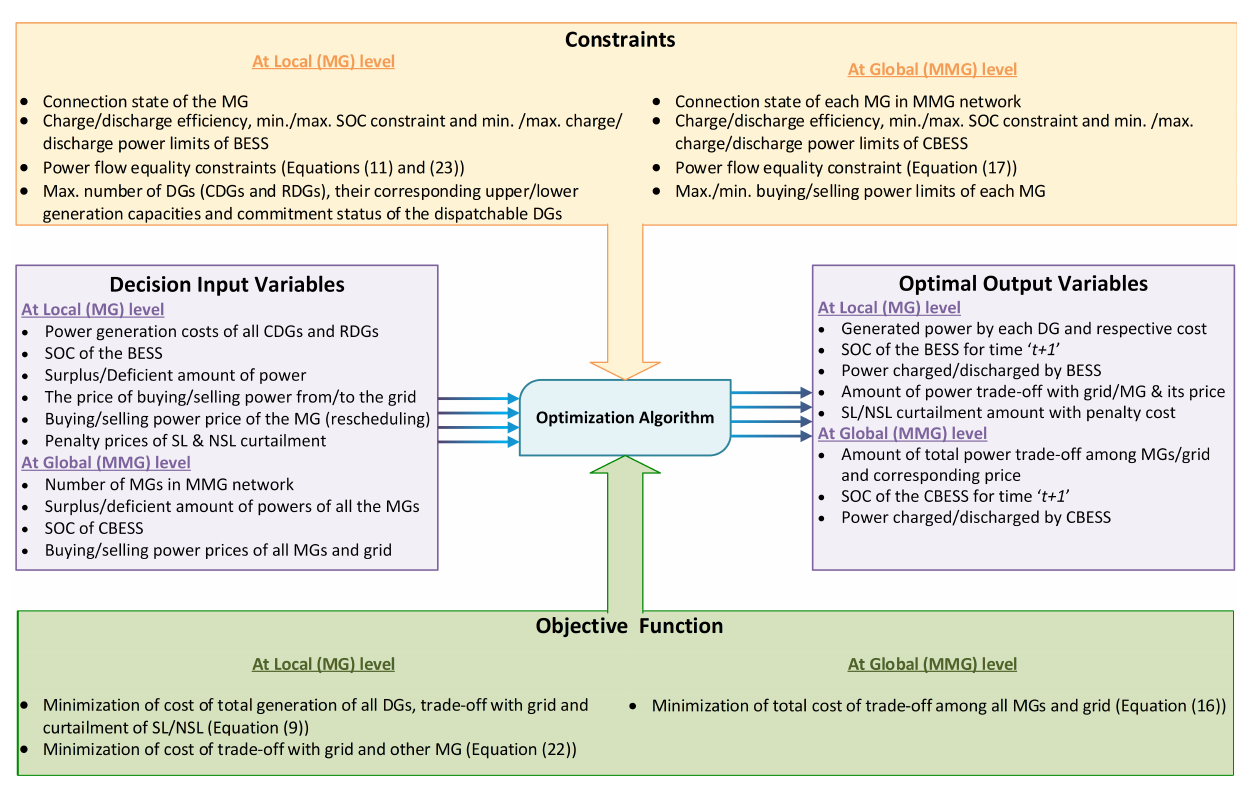
Figure 2. Elements of the optimization